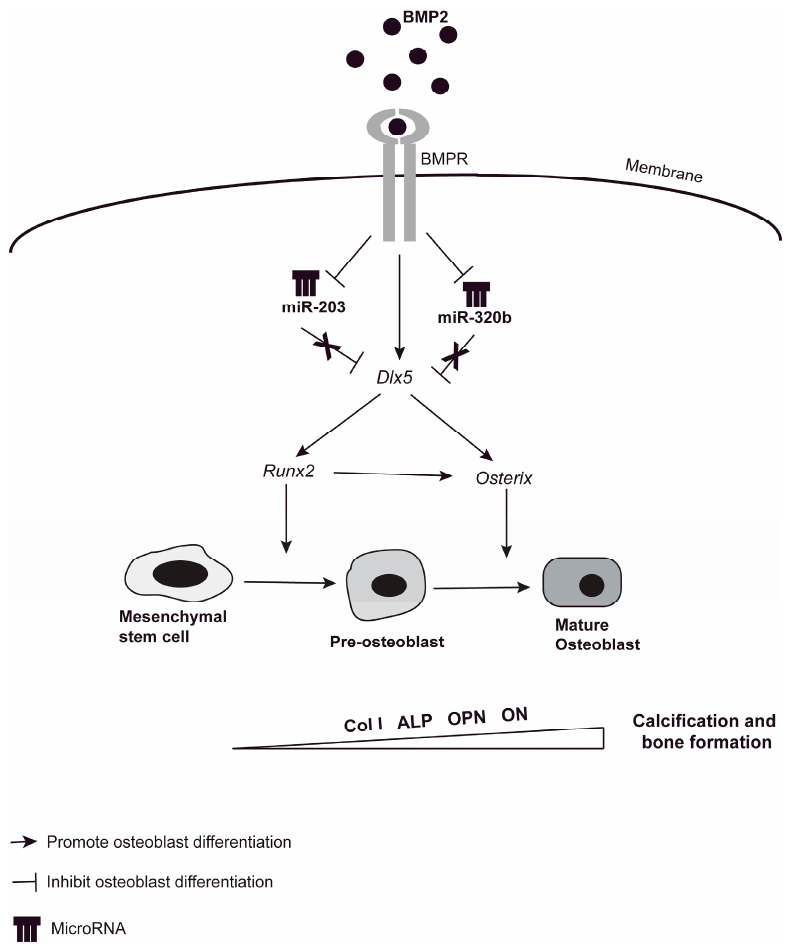
Figure 7. Schematic outline highlighting the complex regulation of BMP ‐ 2 ‐ induced osteoblastogenesis. BMP ‐ 2 binding to the BMP ‐ 2 Receptor (BMPR) activates the canonical BMP signaling pathway that regulates osteoblastic differentiation. Our present results suggest that BMP ‐ 2 downregulates the expression of miR ‐ 203 and miR ‐ 320b, in turn upregulating the transcription factor Dlx5 (Distal ‐ less Homeobox 5). Dlx5 up regulation activates both the transcription factors Runx2 and Osx , promoting osteoblast differentiation. This in turn results in the upregulation of genes important for bone formation and calcification, e.g., collagen type I ( COL1A1 ), alkaline phosphatase (ALP), Osteopontin (OPN) and osteonectin (ON).